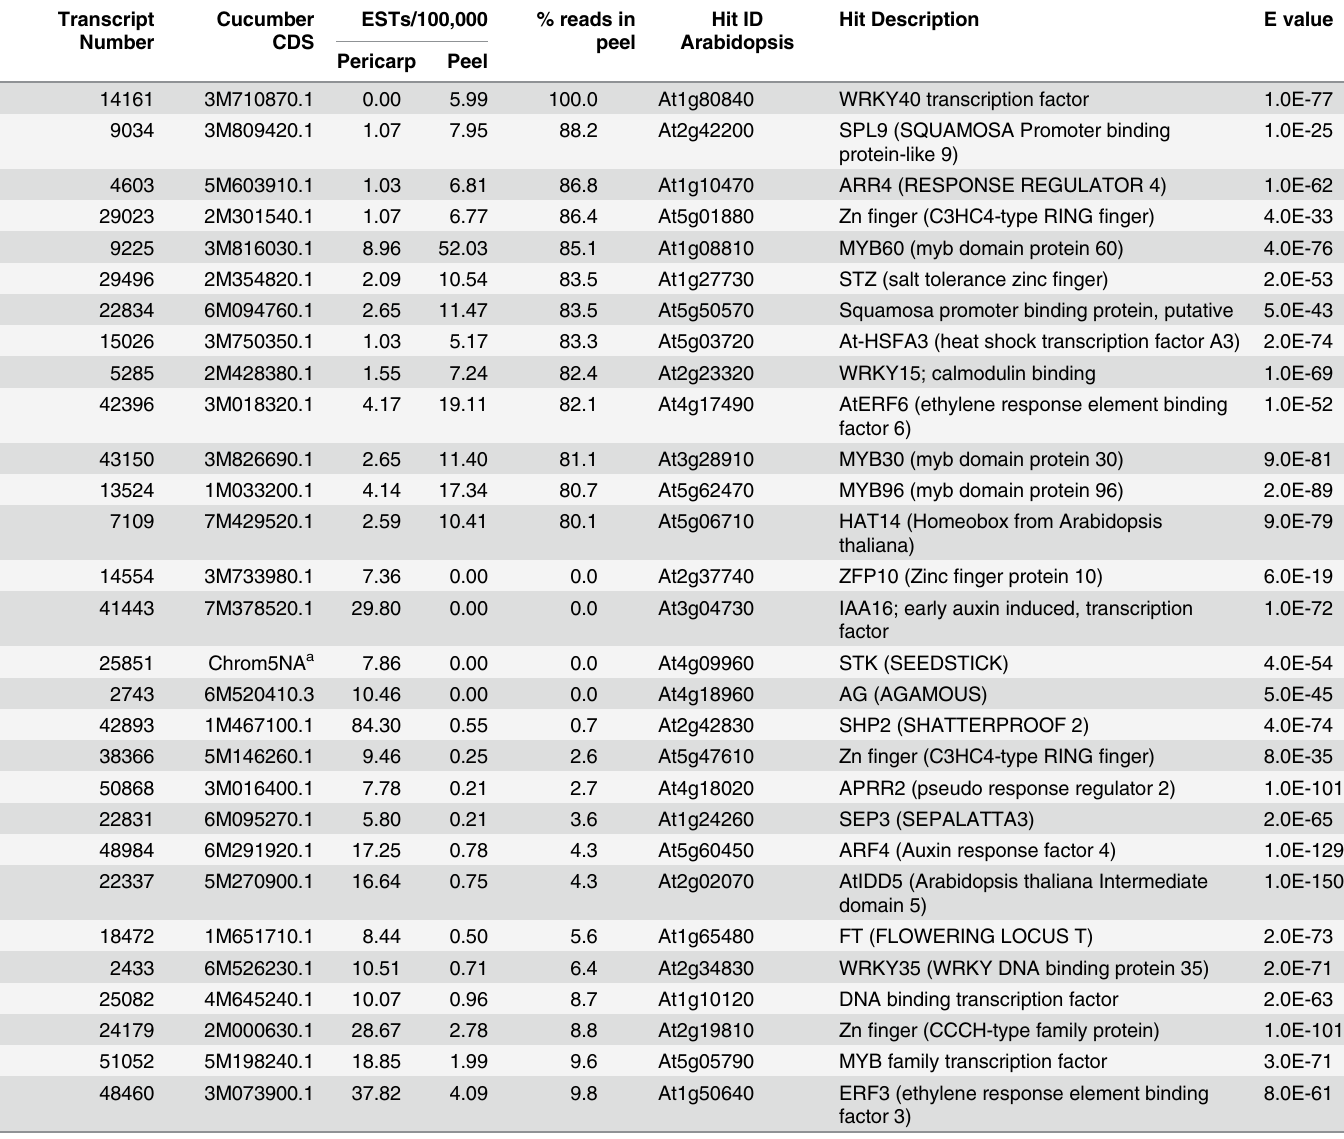
Table 1. Putative transcription factors enriched or reduced in cucumber peel at 8 and 16 days post-pollination. Transcript